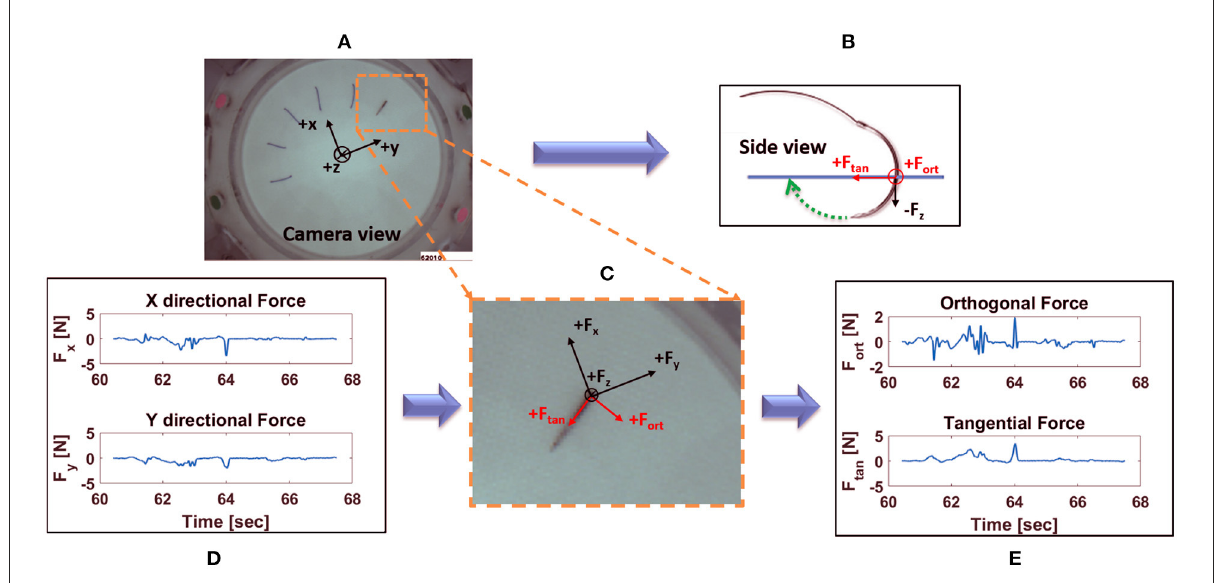
FIGURE7 Decomposition of horizontal forces into forces orthogonal and tangential to stitch direction: (A) view of the needle taken from internal camera with force sensor coordinate system overlaid; (B) side view of the needle along with orthogonal and tangential force direction; (C) zoomed in view of the needle, together with the force sensor, orthogonal and tangential forces; (D) X and Y directional forces at suture location in (A) , for one active suture time; (E) corresponding orthogonal and tangential forces from (A) , for one active suture